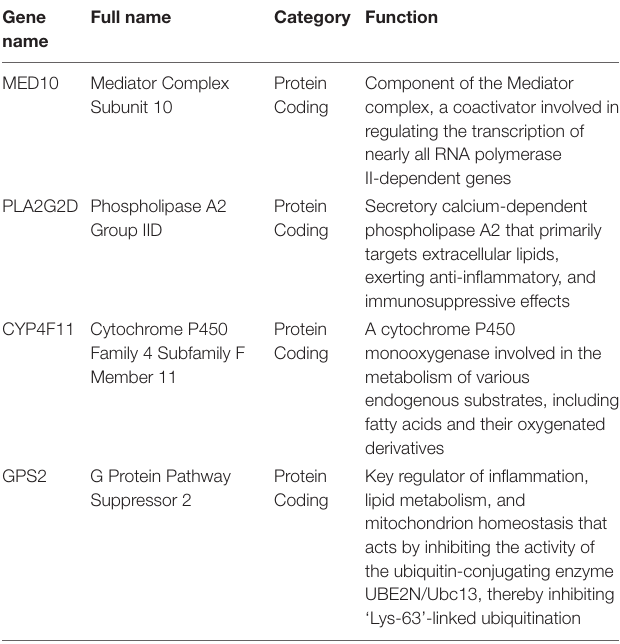
TABLE 2 | Features of the genes used for constructing the risk